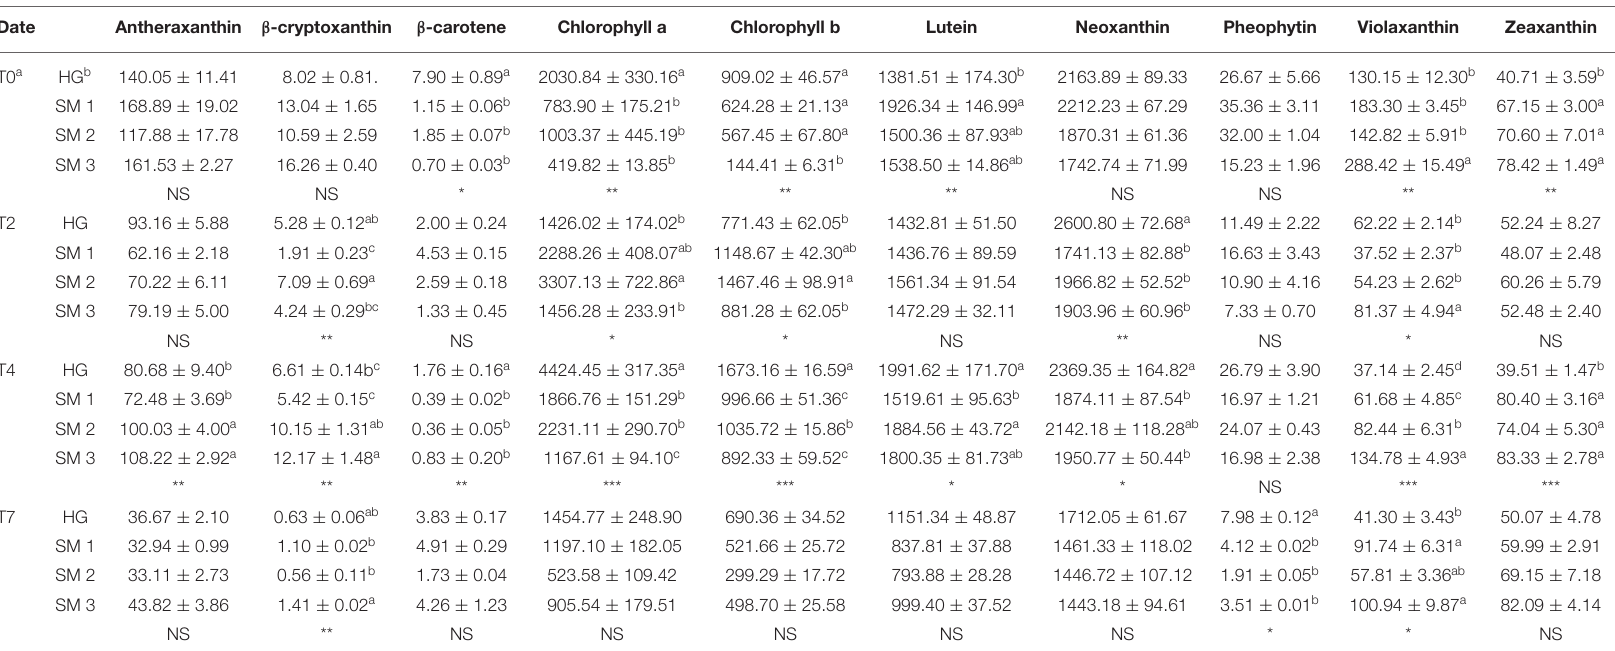
TABLE 3 | Individual carotenoids (mg kg − 1 FW ± SE) in different V. locusta “Vit” samples during refrigerated